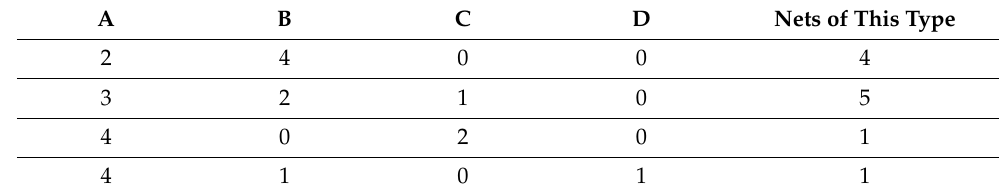
Table 5. The number of possible degree distributions for each type of Platonic solid. Shape of Faces of Unique Degree Distributions Tetrahedron 4 2 Cube 6 4 8 3 Dodecahedron 12 21 Icosahedron 20 9 Menon et al. [31], Pandey et al. [32], Kaplan et al. [33], and Pigrim et al. [34] used